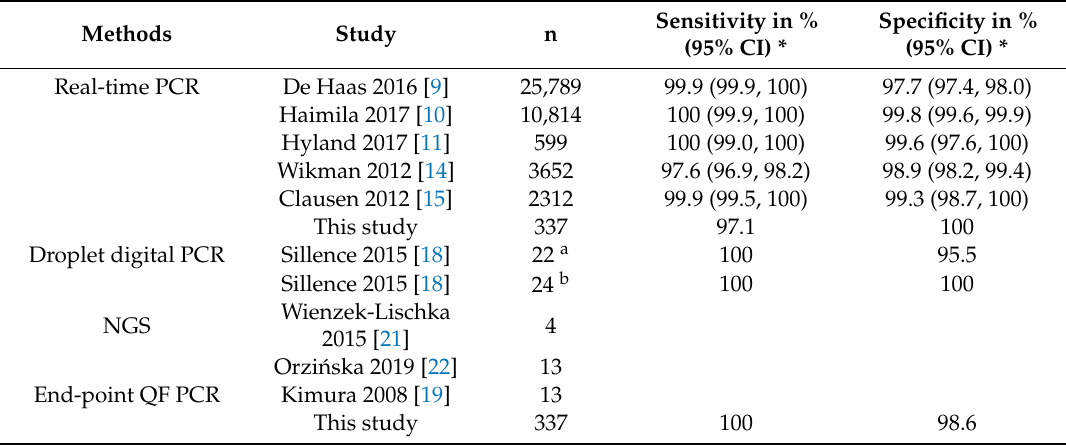
Table 6. Methods used for noninvasive prenatal RHD